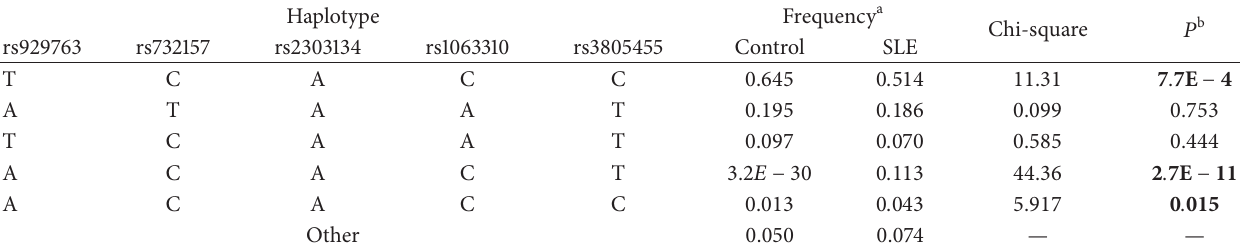
Table 5: Haplotype frequencies of GABRP SNPs in female SLE patients and female healthy controls.